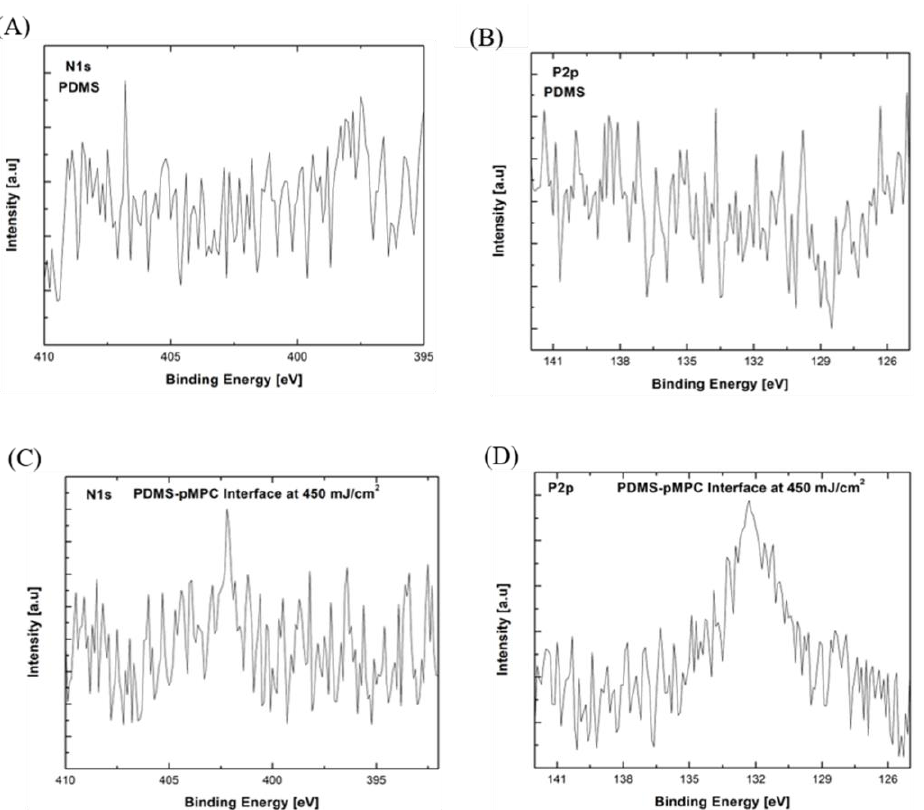
Figure 7. XPS high resolution spectra comparison of the PDMS interface; ( A ) N1s spectra, and ( B ) P2p spectra, and PDMS – pMPC interfaces deposited by MAPLE at 450 mJ/cm 2 ; ( C ) N1s spectra, ( D ) P2p spectra.